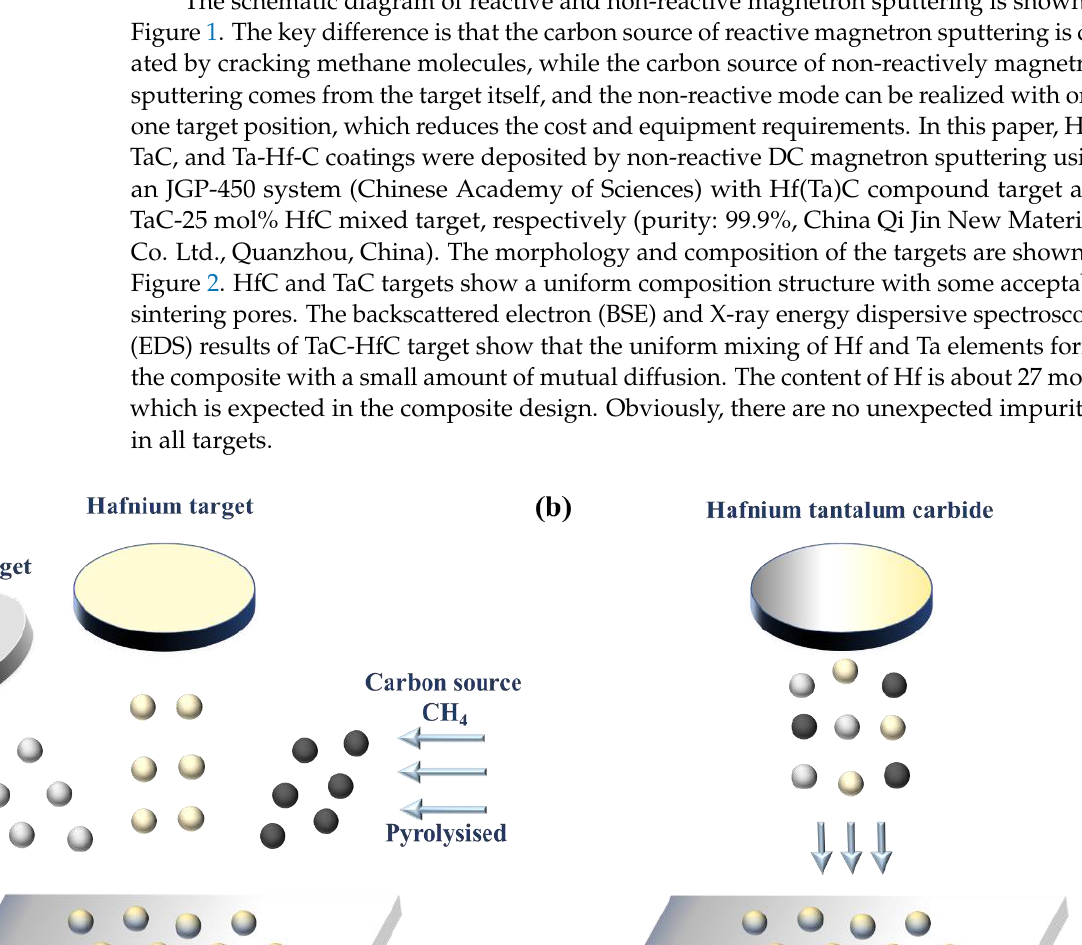
Figure 1. ( a ) Schematic diagram of reactive magnetron sputtered Ta-Hf-C solid solution coating, using pure hafnium and pure tantalum metal targets and methane as carbon source [9]; ( b ) schematic diagram of non-reactively magnetron sputtered Ta-Hf-C solid solution coating, using a hybrid target of HfC and TaC.